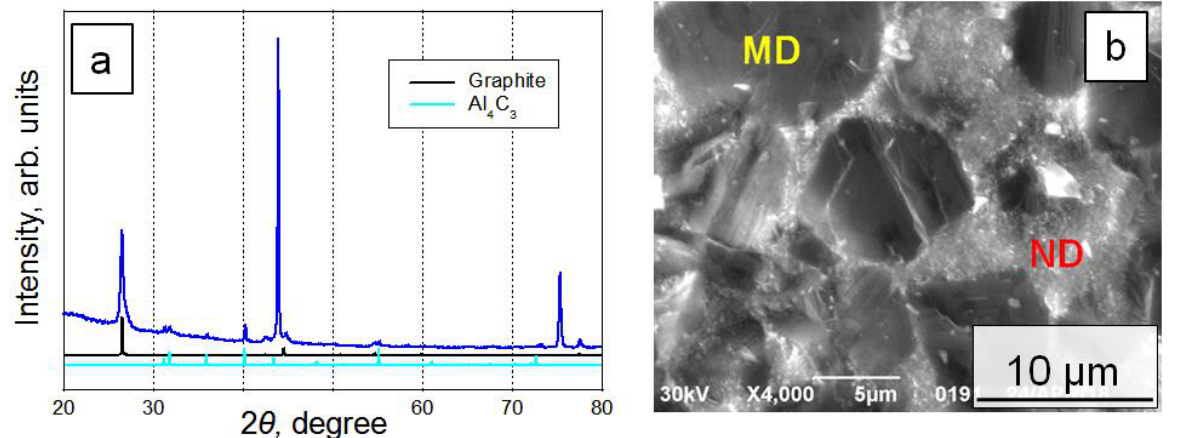
Figure 2. ( a ) X-ray diffraction pattern and ( b ) SEM image of the sample obtained by the sintering of the FDМ -3Al at 8 GPa and 1700 °C (MD — micron-size diamond, ND — nanodiamond).